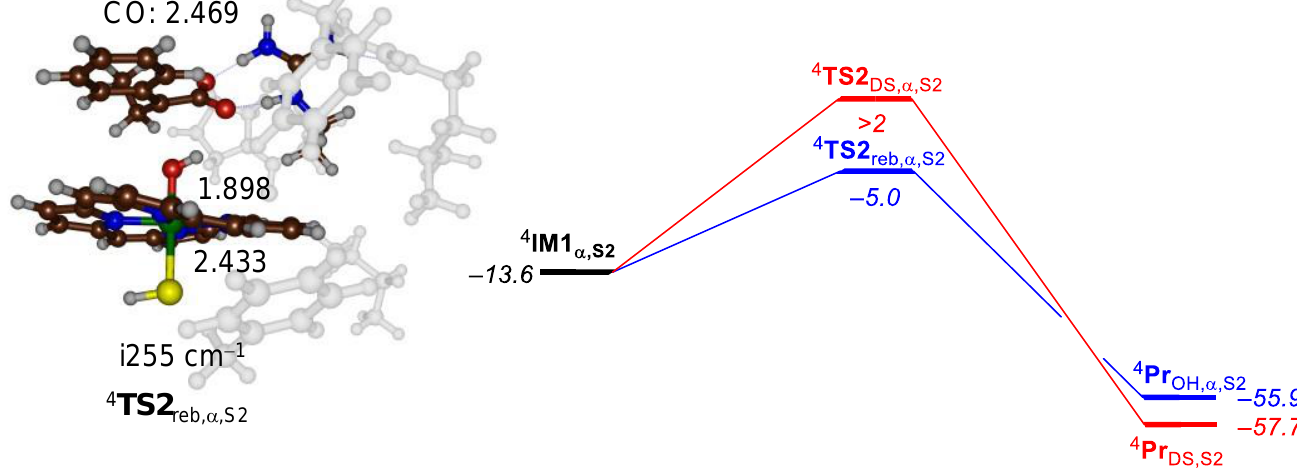
Figure 7. Substrate desaturation and hydroxylation bifurcation pathways for substrate S2 from the radical intermediate IM1 α ,S2 of P450 OleT JE . The right-hand side shows energies relative to 4 R e S2 in kcal mol − 1 as obtained at the ∆ E+ZPE level of theory. The rebound transition state structure is shown on the left with bond lengths in angstroms and the imaginary frequency in the transition state in cm − 1 . The desaturation transition state energy was estimated from constraint geometry scans.